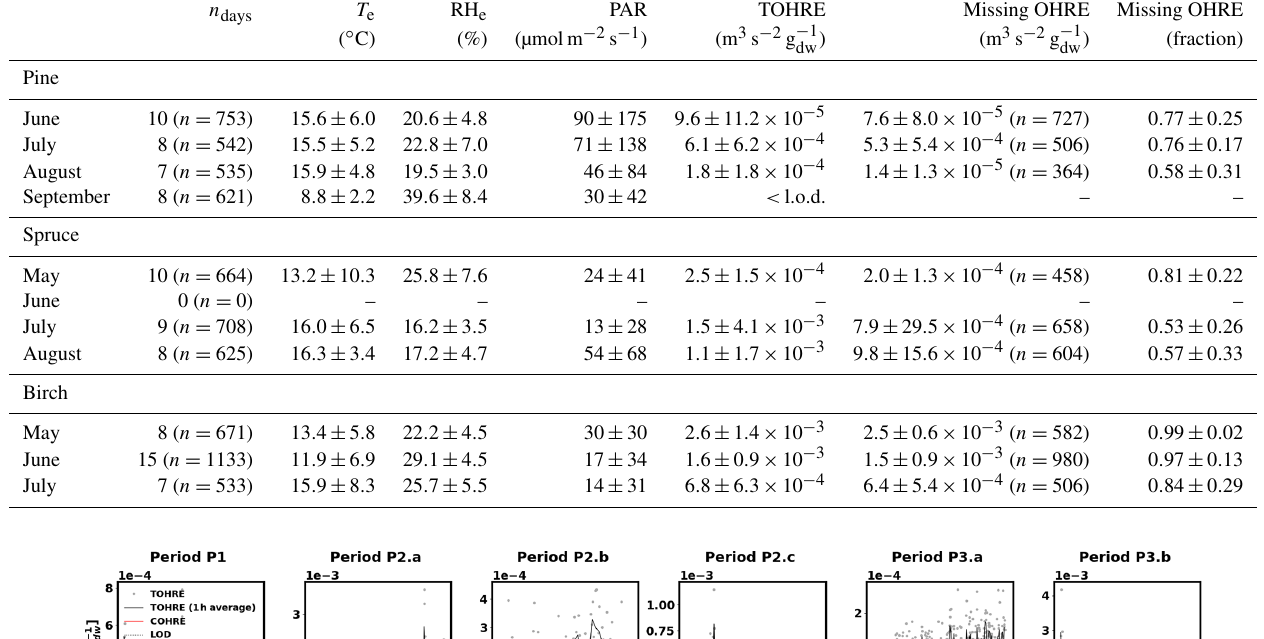
Table 1. Monthly averages of temperature ( T e ) and relative humidity (RH e ) in the branch enclosure, photosynthetically active radiation (PAR) measured just above the enclosure, and total OH reactivity of the emissions (TOHRE), as well as missing OHRE (absolute and relative). The number of observations, n , for missing OHRE is lower than for other parameters due to an incomplete overlap between calculated OHRE (VOC data) and TOHRE.